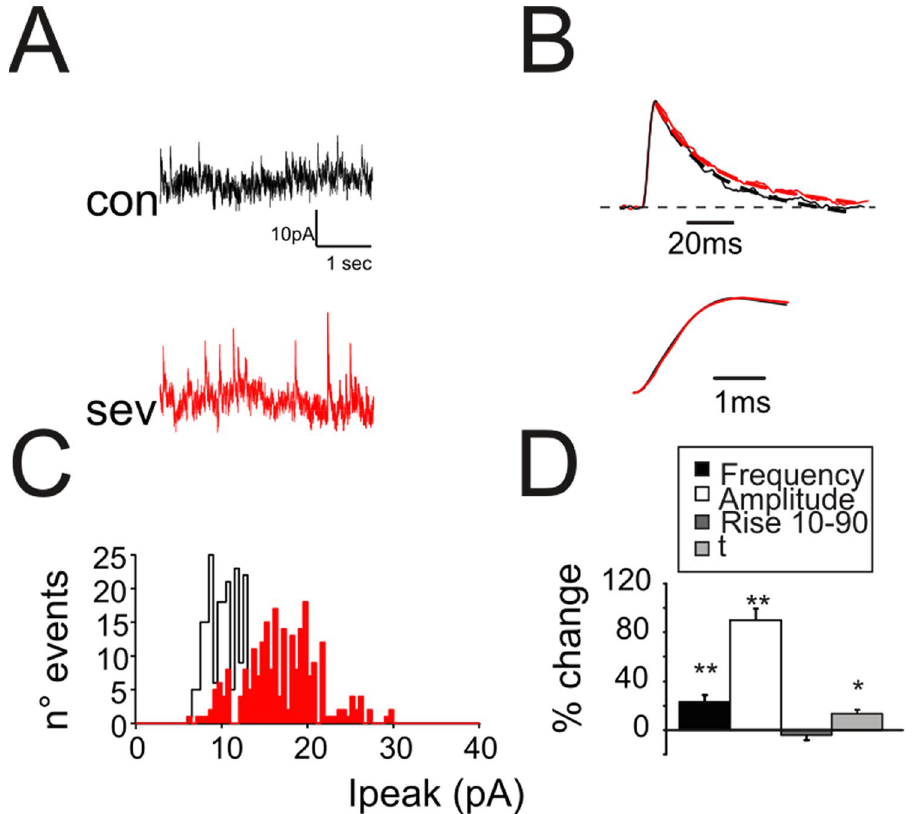
Figure 3. Modulation by sevoflurane of spontaneous inhibitory synaptic currents. ( A ) sIPSCs recorded from a granule cell before (black) and after (red) the application of sevoflurane. Note the increased frequency and peak amplitude. ( B ) Normalized sIPSCs recorded from a granule cell before (black) and during (red) sevoflurane application. The mono-exponential fitting (dashed lines) of the current relaxation reveals small changes in decay. Bottom: rise time of the sIPCSs shown in the upper panel. ( C ) Distribution of sIPSCs peak amplitudes detected during a recording of 3 min in control condition (black histogram) and in the presence of sevoflurane (red). ( D ) Histogram shows the effects induced by sevoflurane on sIPCS biophysical properties (n =